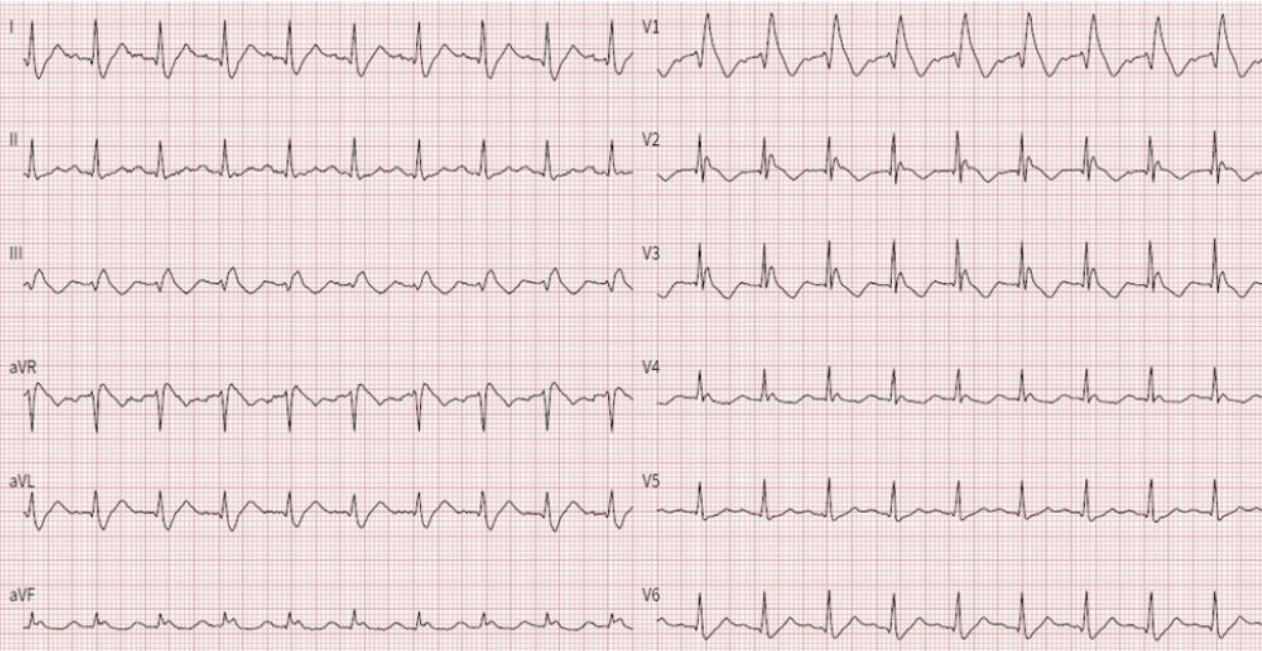
Figure 1. Rest 12-lead ECG of the proband during admission at emergency department for syncope, showing Brugada type 1 ECG pattern.